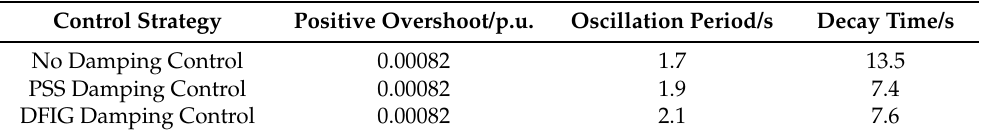
Table 3. Dynamic performance of optimized damping control.